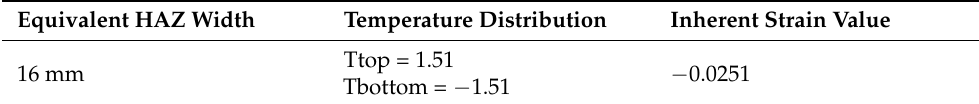
Figure 15. Angular distortion: multi-pass SDB method (mm unit).